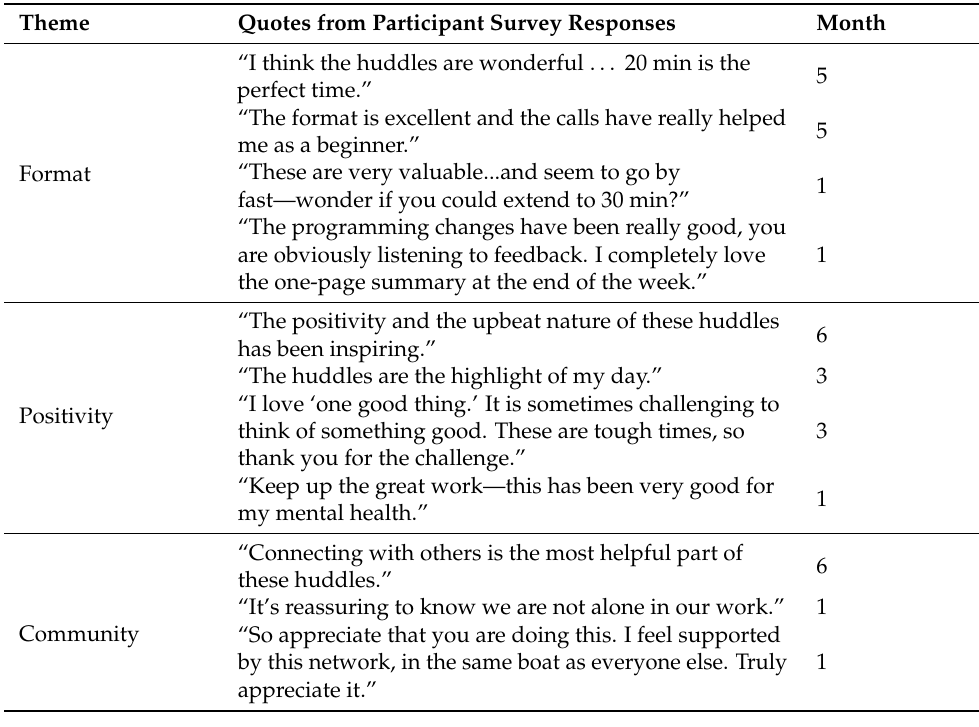
Table 3. Selection of RRN huddle qualitative experiential results from monthly surveys.